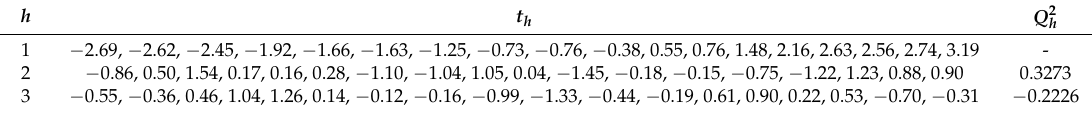
Table 3. Extracted components and the corresponding cross-validation.